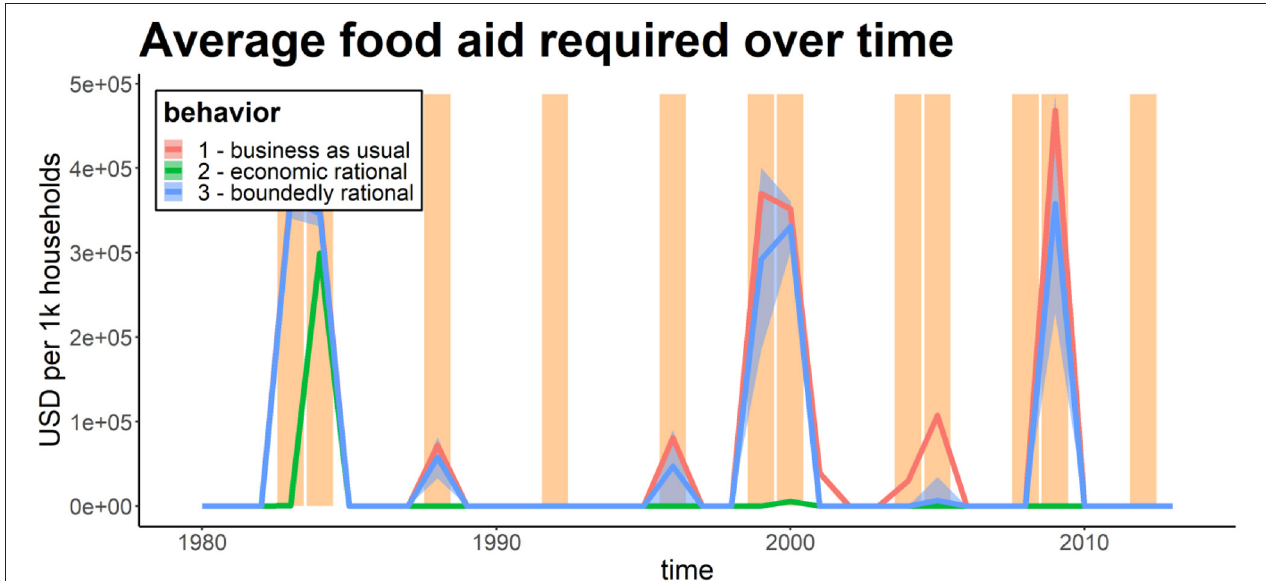
FIGURE 8 | Food aid required per thousand households. Food aid was calculated as the cumulative amount of food shortage of all individual households multiplied by the maize price, accounting for a variable food price. Variability over time is visualized for three behavioral scenarios: economic rational (EUT), bounded rational (PMT), and no adaptation decisions (BAU). Drought years (SPEI value in crop season < − 1) are visualized as vertical orange bars. The shaded blue area shows the variance among 50 bounded rational model runs, a result of the variety in weights of the PMT factors.